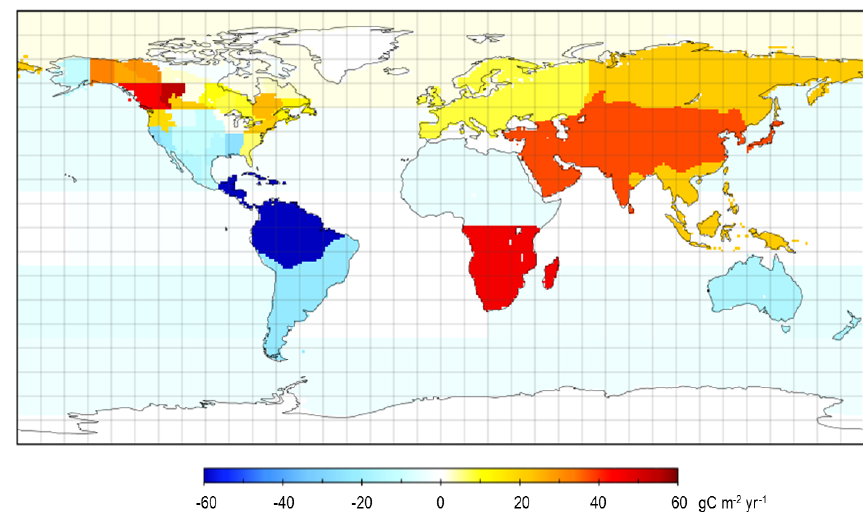
Figure 9. Difference of the inverted CO 2 flux between using CO 2 + 13 CO 2 data and using CO 2 data only (2002–2004